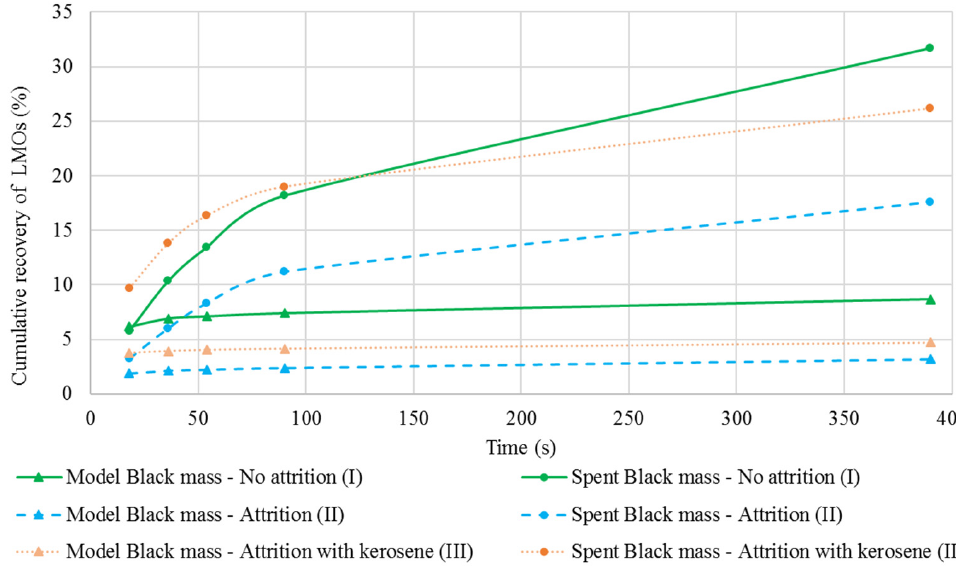
Figure 8. Recovery of the LMOs from spent black mass and model black mass in the overflow product according to the flotation time.